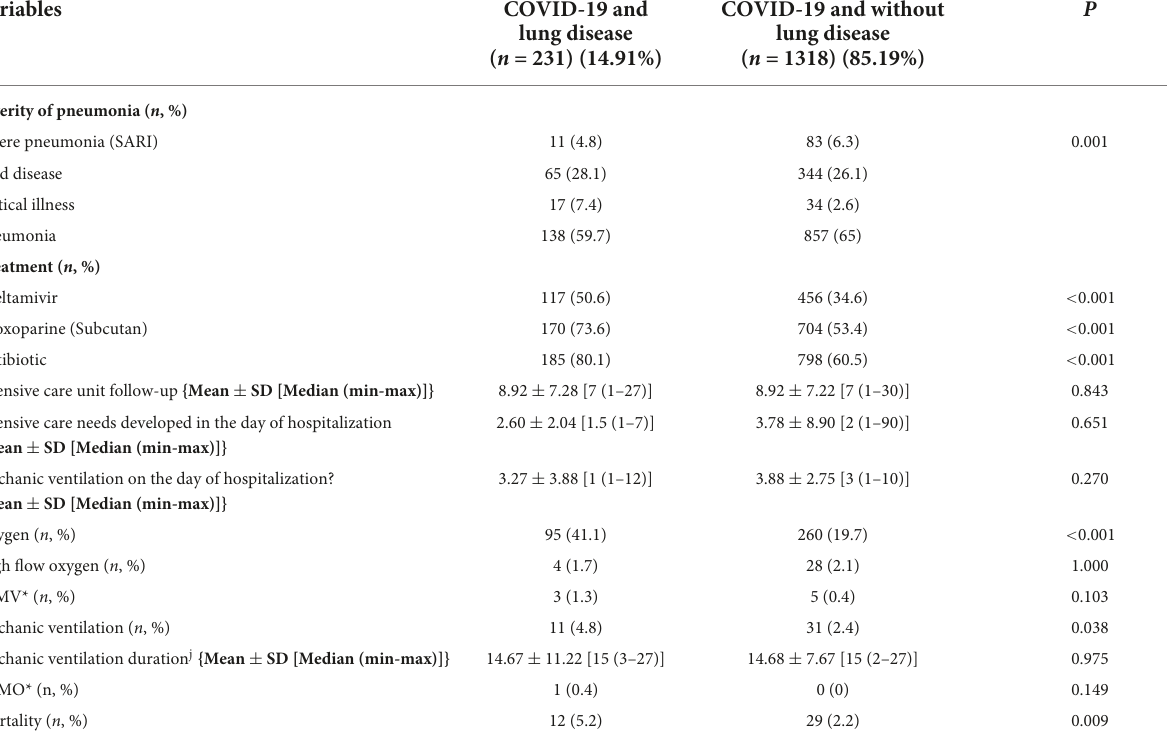
TABLE 2 The severity of pneumonia follow-up parameter of patients with chronic disease (Group 1) and without chronic lung disease (Group 2). Variables